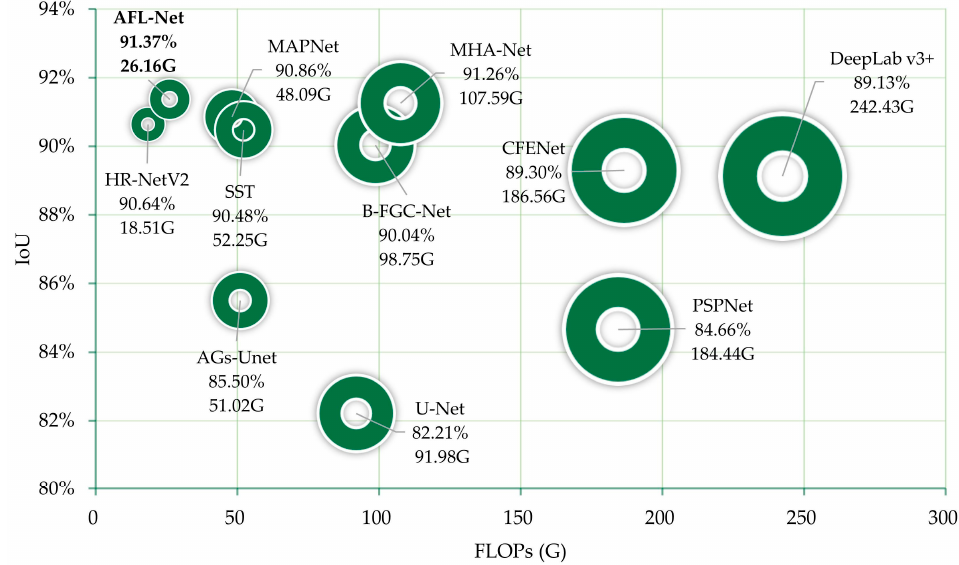
Figure 14. Comparison of the accuracy and complexity of selected models, annotated with IoU and computational cost in each model.